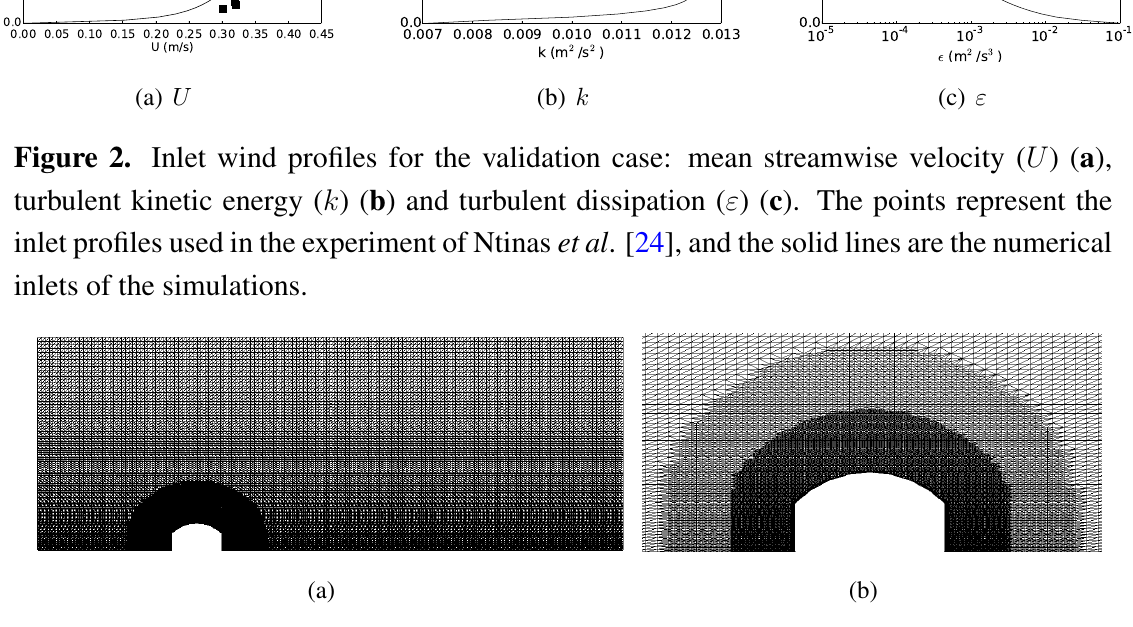
Figure 3. Vertical section of the refined mesh obtained using snappyHexMesh for the validation case. ( a ) General view mesh, 6.5 M cells; ( b ) detail of the refinement area.